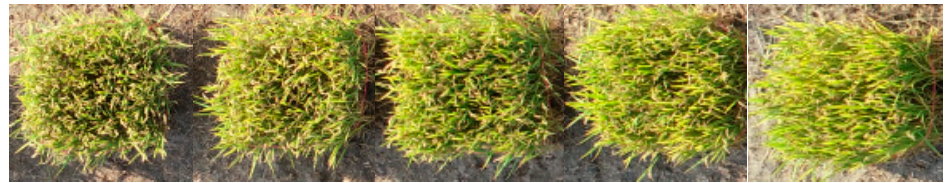
Figure 4. Random selection of five groups of field rice.